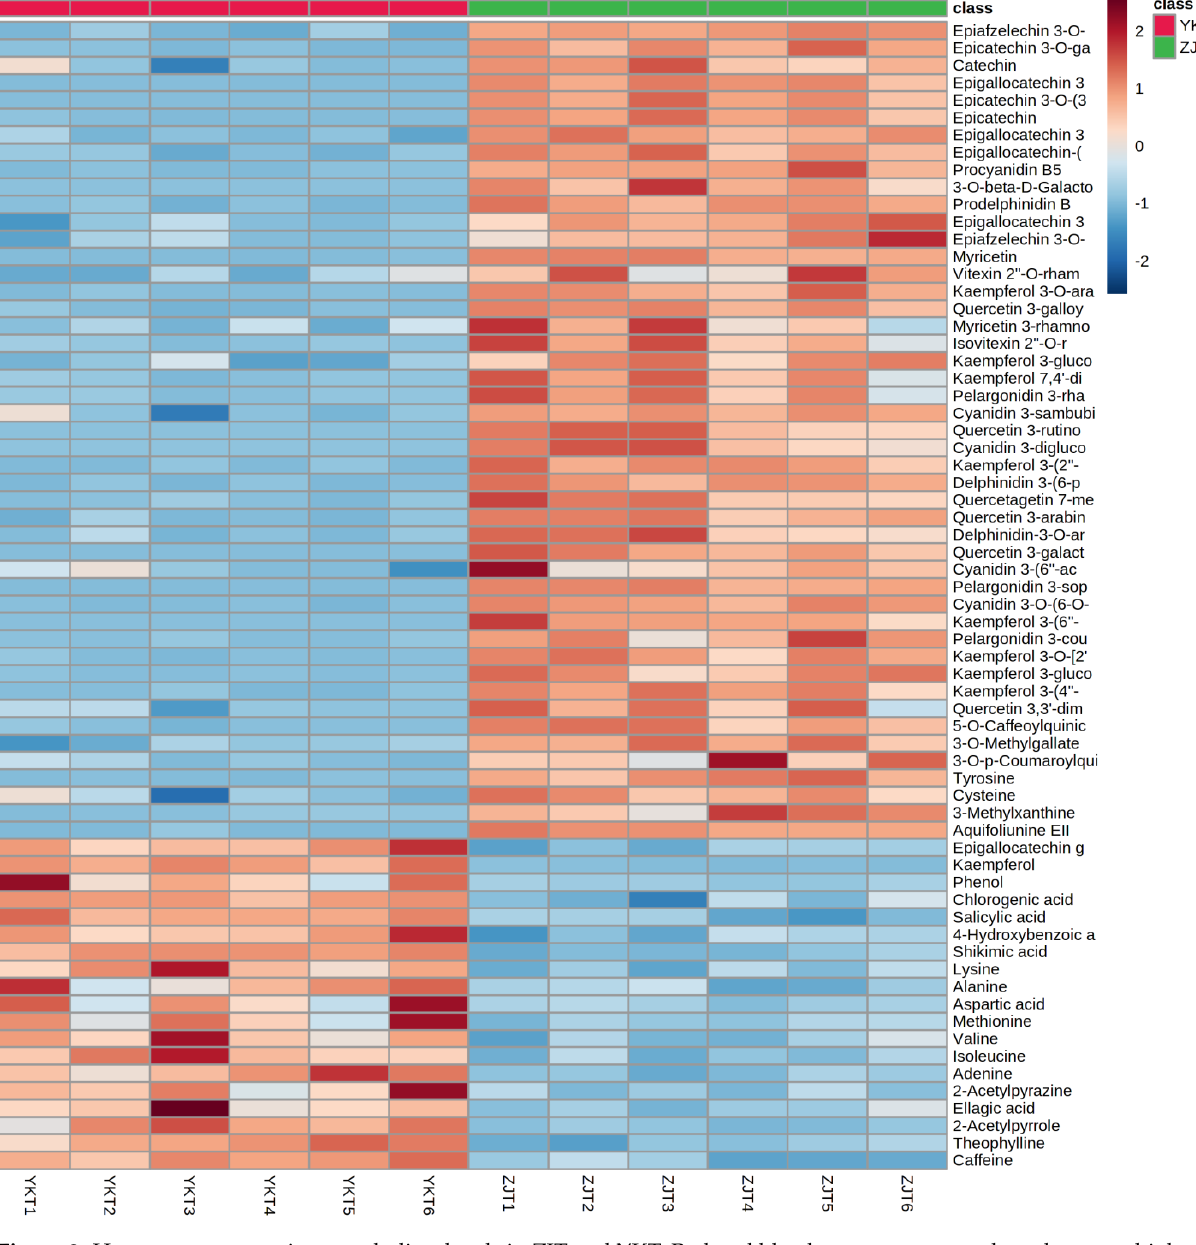
Figure 2. Heat map representing metabolites levels in ZJT and YKT. Red and blue boxes represent values that were higher and lower than the mean value, respectively.